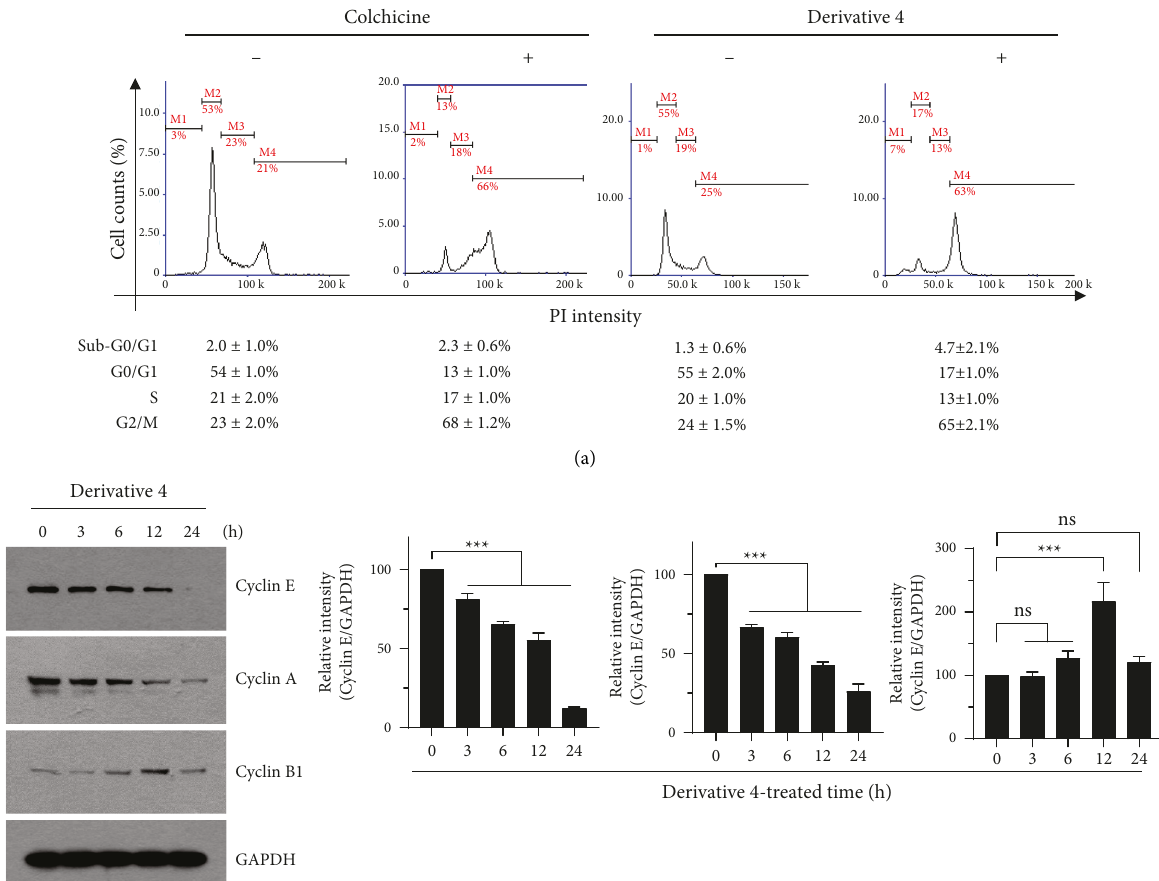
Figure 5: effect of derivative 4 on cell cycle progression. (a) HCT116 cells were either untreated or treated with 100ng/mL colchicine or 40 μ M derivative 4 for 24h. The cellular DNA was stained with propidium iodide, and the DNA contents were determined by flow cytometry. M1, sub-G0/G1; M2, G0/G1; M3, S; and M4, G2/M. x-axis, DNA contents; y-axis, cell counts (%). Data represent mean ± S.D. ( n � 3). (b) HCT116 cells were treated with 40 μ M derivative 4 for different time periods. Total cell lysates were prepared and subjected to immunoblotting using antibodies against cyclin E cyclin A and cyclin B1. GAPDH was used as a loading control. For the quantification, the relative band intensity corresponding to each protein was normalized to the GAPDH level using ImageJ software. Data are expressed as mean ± S.D. ( n � 3). ns, not significant; ∗∗∗ P < 0 . 001 ( n � 3) by the Dunnett’s multiple comparison